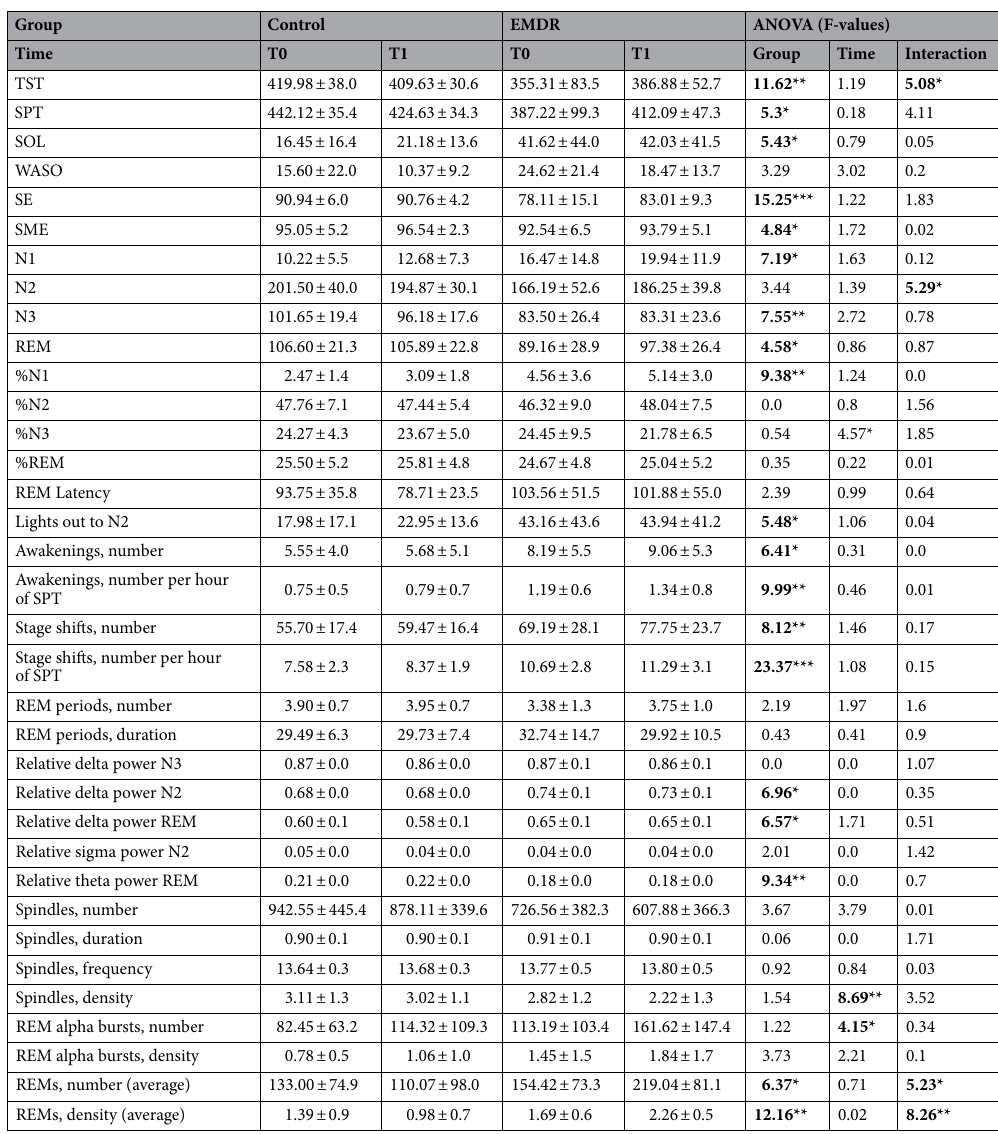
Table 2. Sleep parameters. Significant F-values are in bold. TST total sleep time, SPT sleep period time, SOL sleep onset latency, WASO wake after sleep onset, SE sleep efficiency, SME sleep maintenance efficiency.